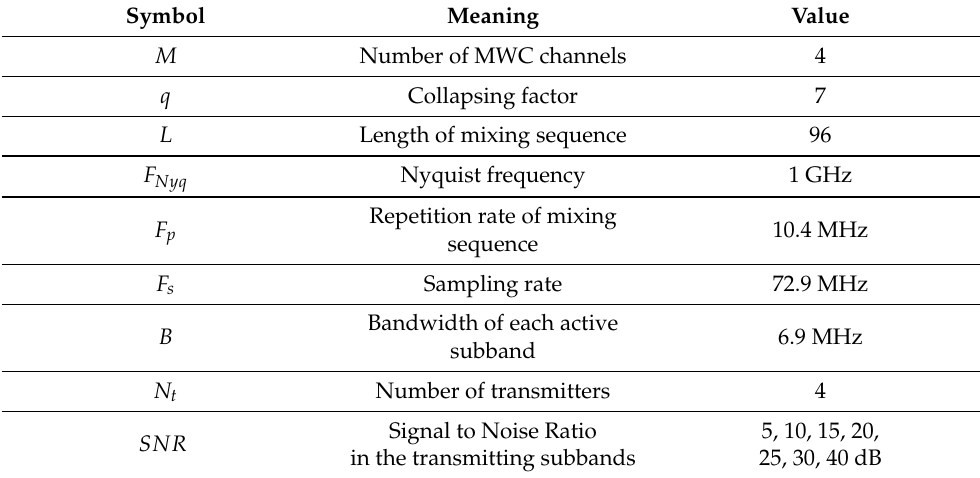
Table 2. Parameters of MWC